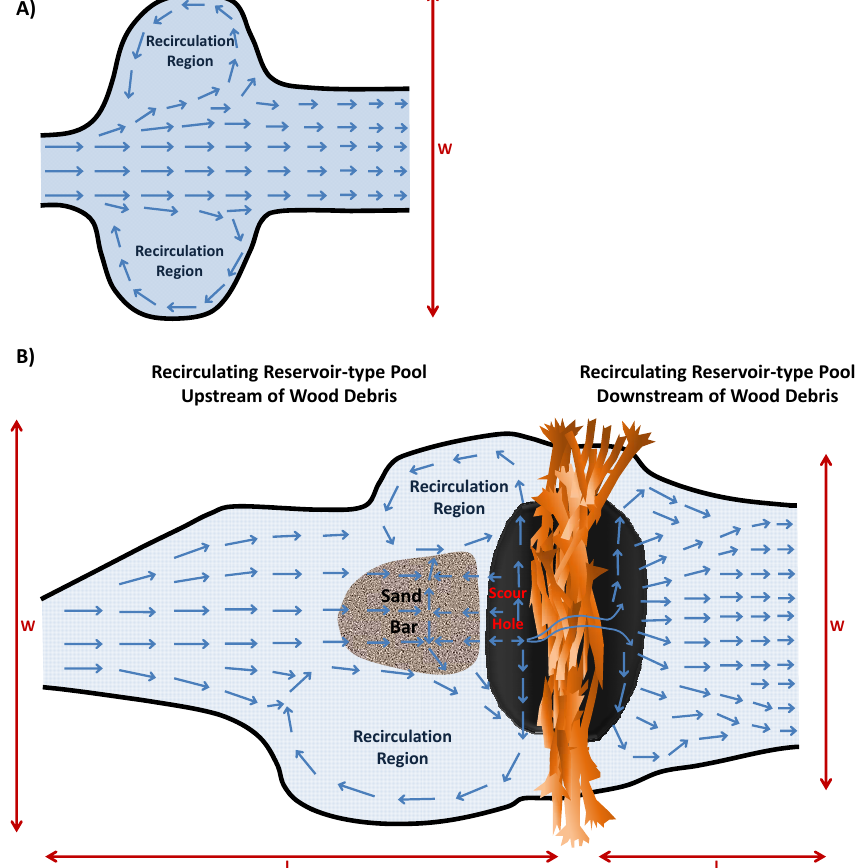
Fig. 12. Schematics illustrating three different flow field examples of recirculating reservoir-type pools. (A) A jet-like flow forms recirculation regions on each side of the pool near the entrance. (B) (left-hand side) Upstream of in-channel obstacle, flow impingement forms recirculation regions near streambanks and a deep recirculating flow in scour hole. (B) (right-hand side) Downstream of in-channel obstacle, vertical jet- like flow enters pools and forms deep recirculating flow in scour